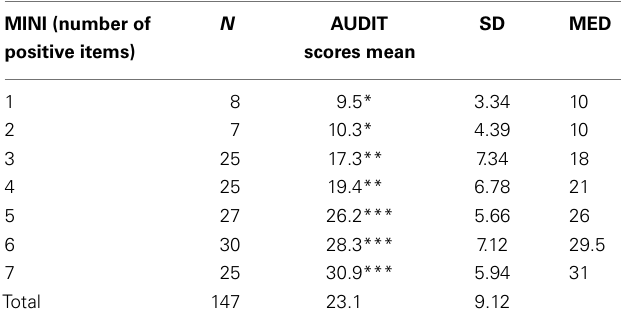
Table 1 | Mean scores of theAUDIT according to number of DSM-IV criteria